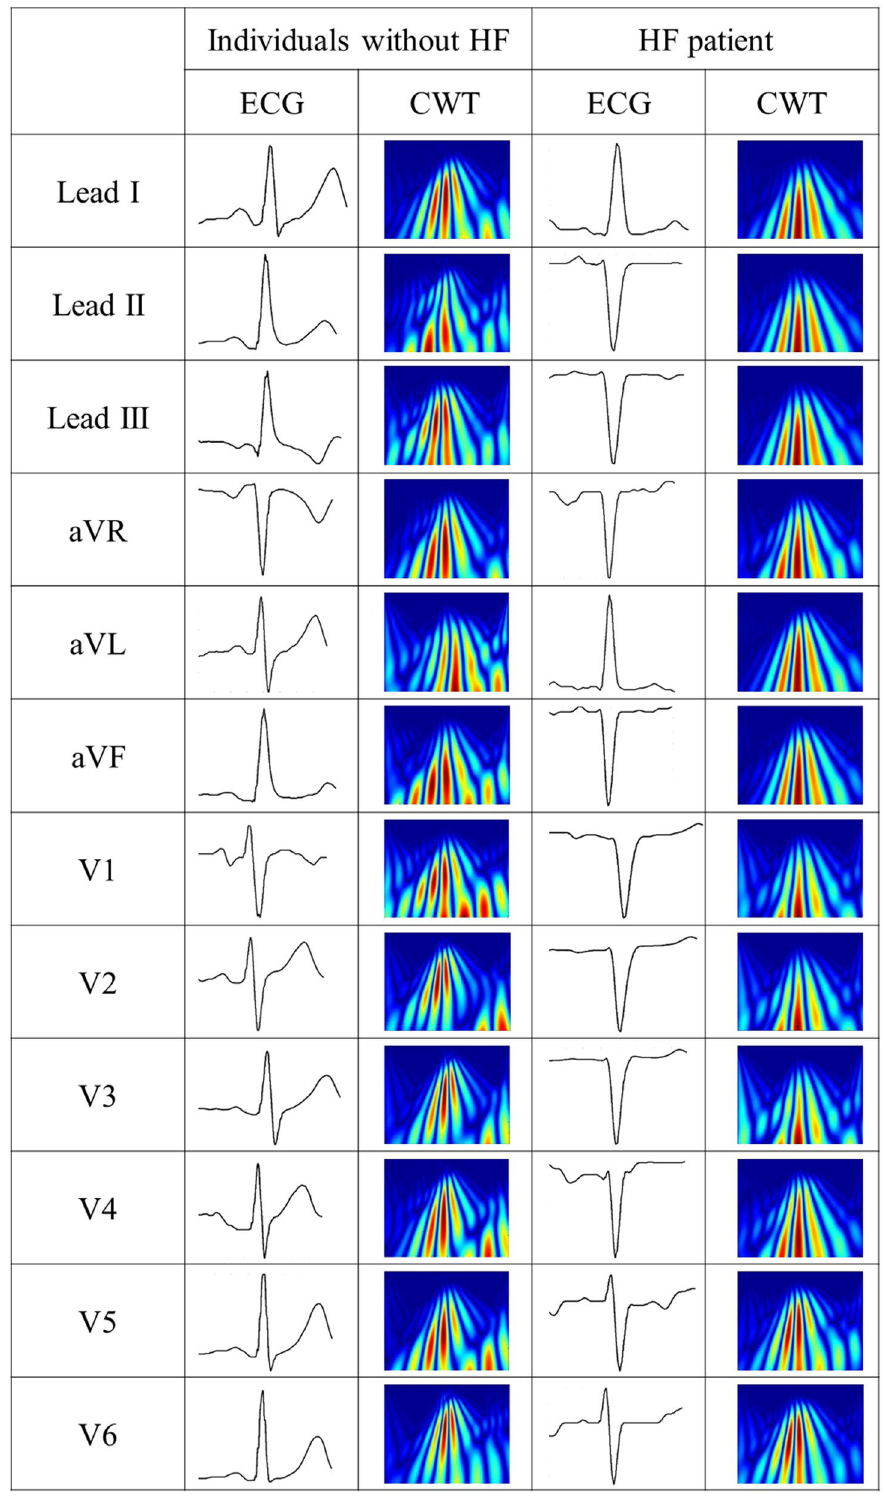
Figure 5. Illustration for the CWT of the 12-lead ECG. The original image of the ECG JPG file and CWT spectra were